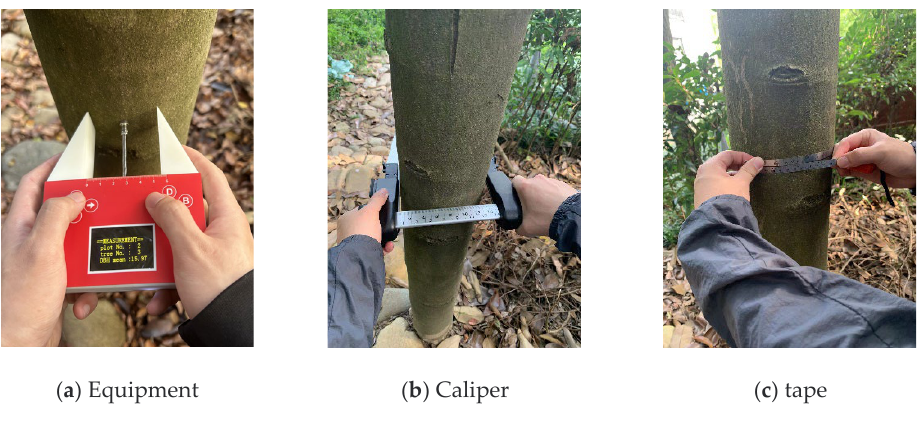
Figure 7. Field measurement map .